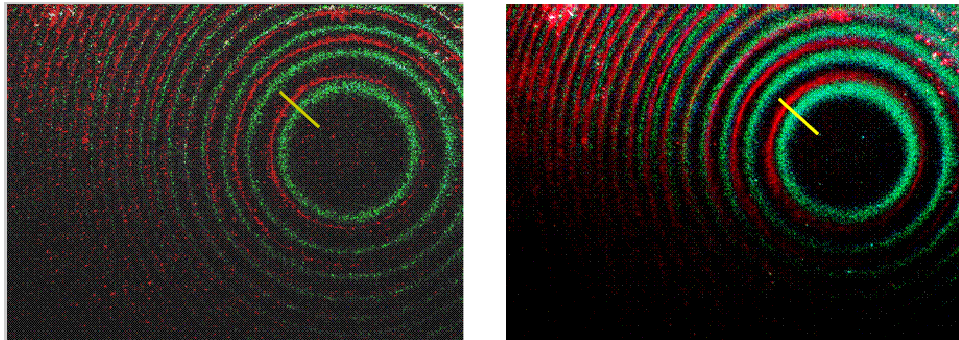
Figure 6. Comparison of the optical microscope images of the trapped rainbow effect from Figure 5(c) (right panel) and the image obtained when only two laser wavelengths (514 nm and 633-nm) are used for illumination (left